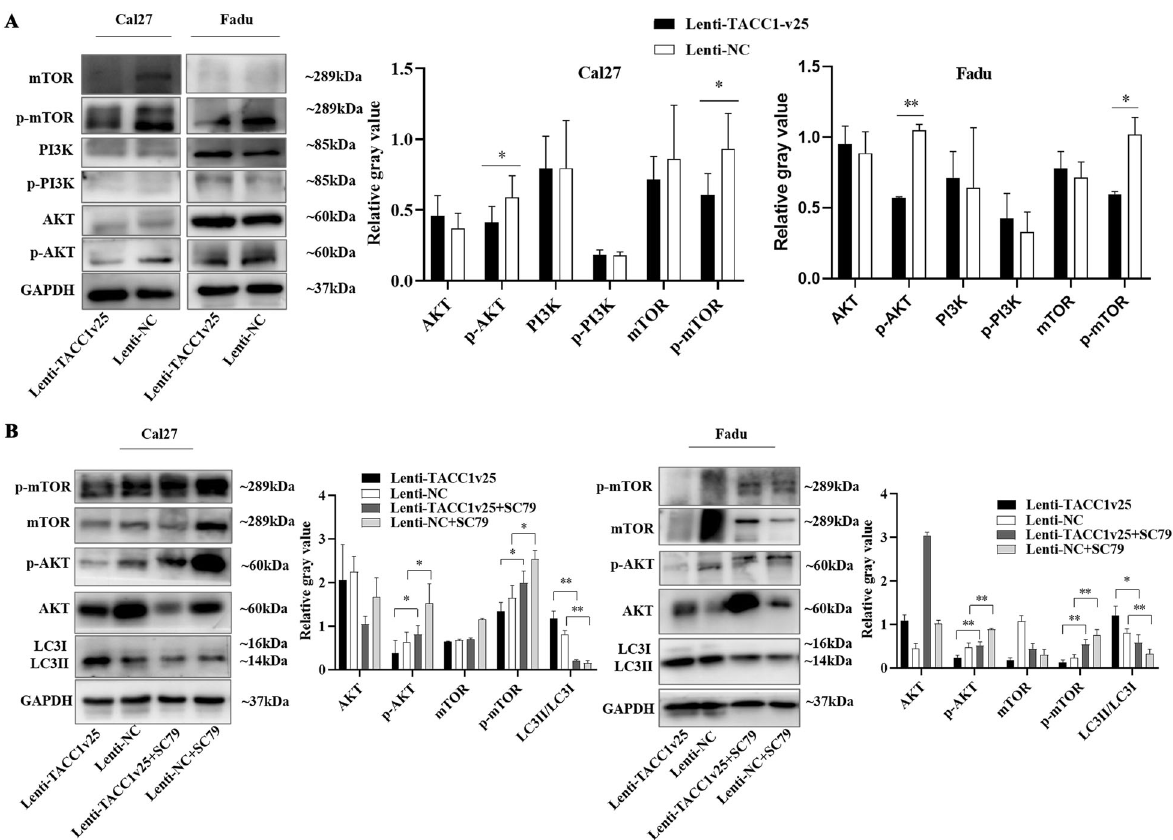
Fig. 6 TACC1v25 inhibits activation of the PI3K/AKT/mTOR signalling pathway. A Western blot analysis of PI3K/AKT/mTOR. Expression of p-AKT and p-mTOR is decreased in Lenti-TACC1v25-Cal27/-Fadu cells. B After addition of the AKT activator, SC79, expression levels of p-AKT and p-mTOR are increased, and LC3II/LC3I is decreased in Lenti-TACC1v25-Cal27/-Fadu cells. * P < 0.05, ** P < 0.01, *** P < 0.001.